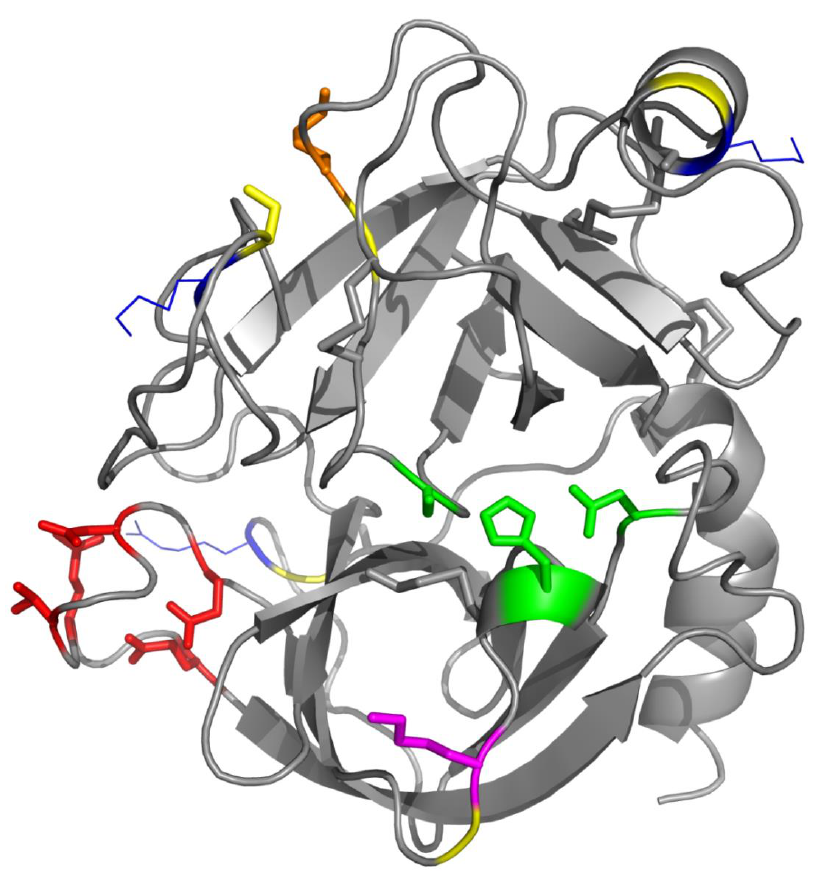
Figure 3. The crystal structure of bovine β-trypsin. This overall view was made in PyMOL 1.3 using a pdb formatted file (accession number 1AQ7 [41]) downloaded from the PDB database (http://www.rcsb.org/pdb). Trypsin fold comprises two β-barrels. The active site with the catalytic triad of amino acids is located between them (in the center of this figure) and highlighted in green. Red color on the bottom left shows the calcium-binding residues. The KD bond, which is cleaved to generate ψ-trypsin is expressed as an orange side chain (Lys-176) at a yellow backbone segment (Asp-177). Blue-line side chains at other yellow segments indicate the presence of the basic residues, where the β-trypsin polypeptide chain is cleaved to produce α-trypsin (Lys-131, above the calcium site and not far away from Lys-176 in this projection), γ-trypsin (Lys-155, top right, in the helix), and δ-trypsin (Arg-105, behind the calcium site). Finally, magenta color at the bottom indicates Lys-49, which is disconnected from Ser-50 to yield the inactive autolytic form.